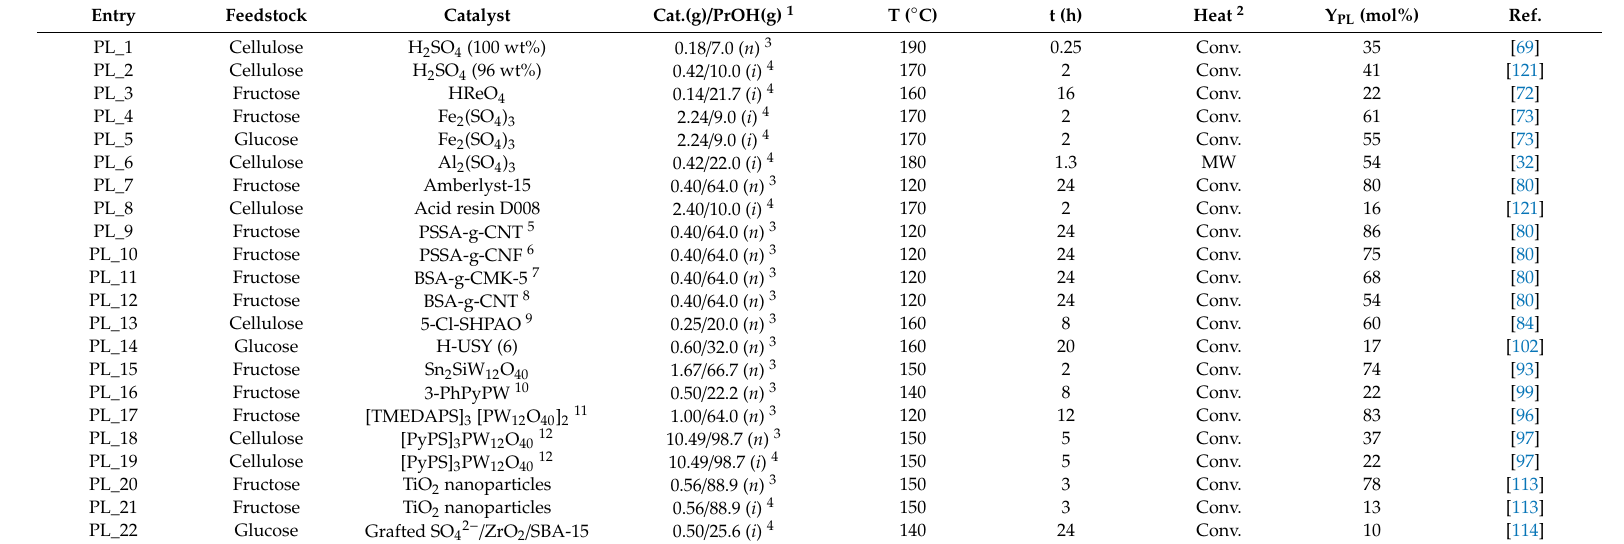
Table 13. Catalysts for the PL production from C6 model